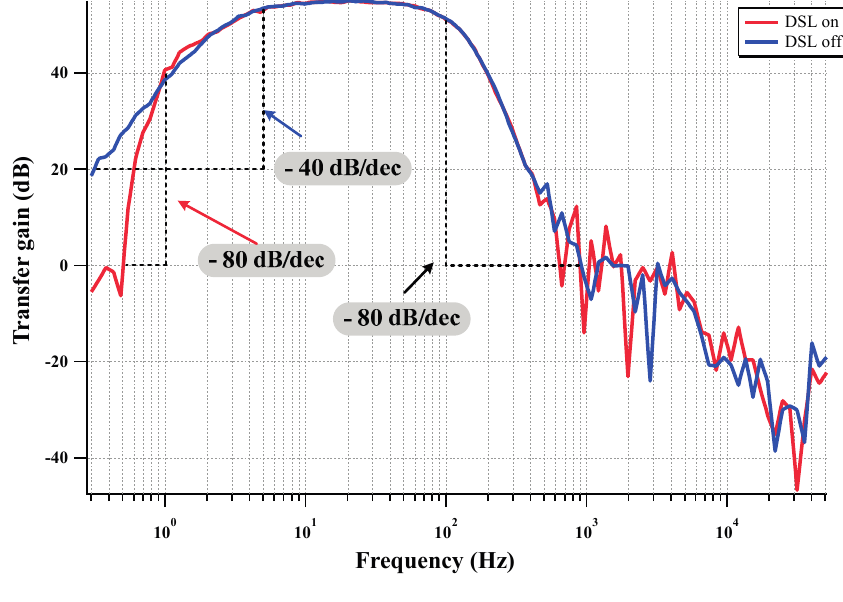
Figure 14. Measured frequency response of the DSL activation.